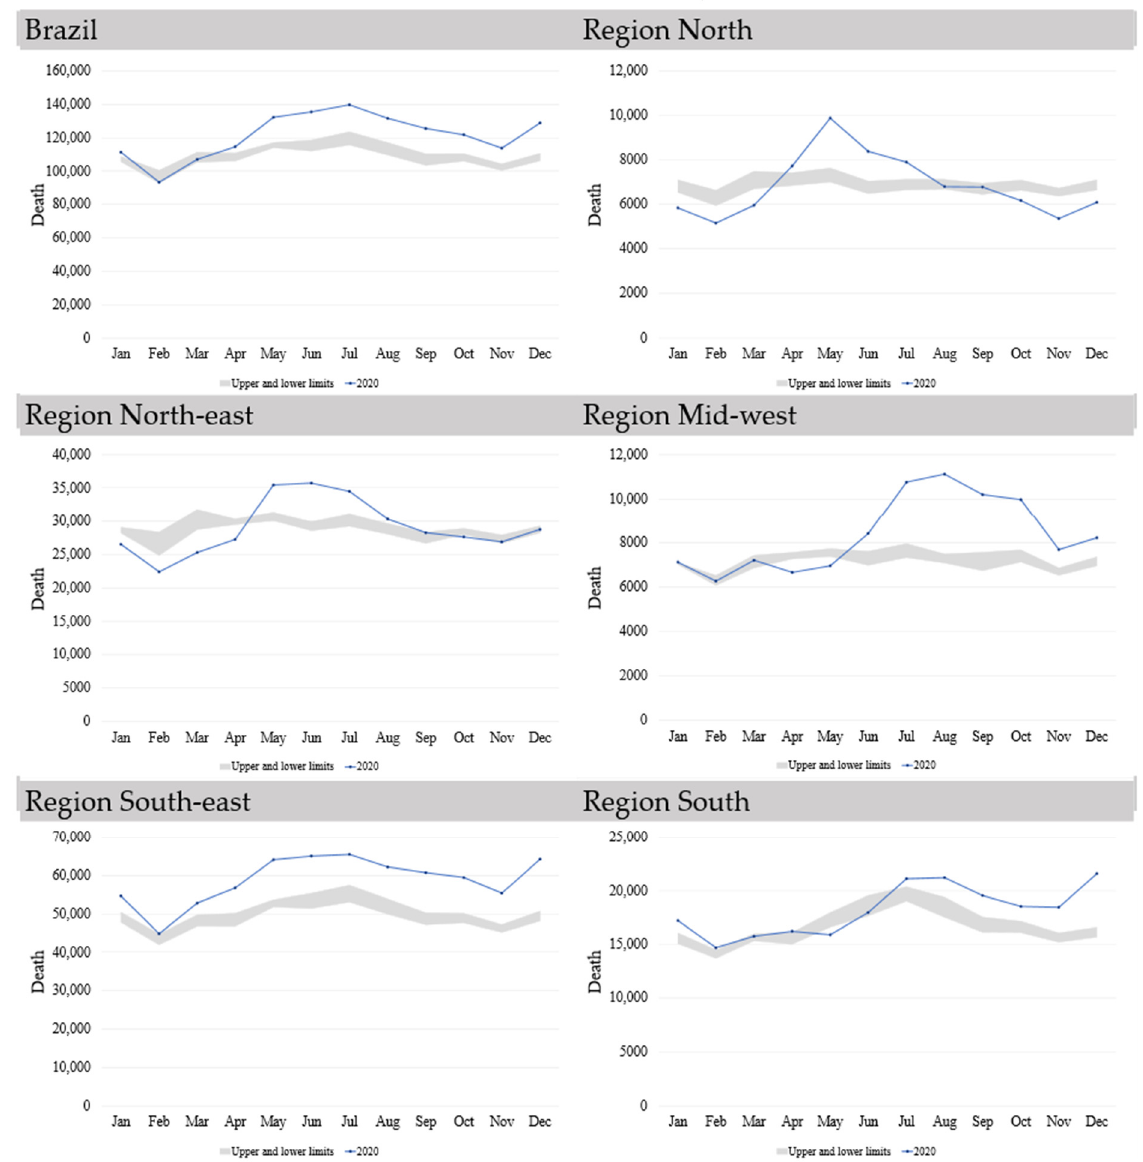
Figure 5. Excess mortality in Brazil (2020). Deaths per month compared with upper and lower limits (95% CI) of historical averages in Brazil and its regions.